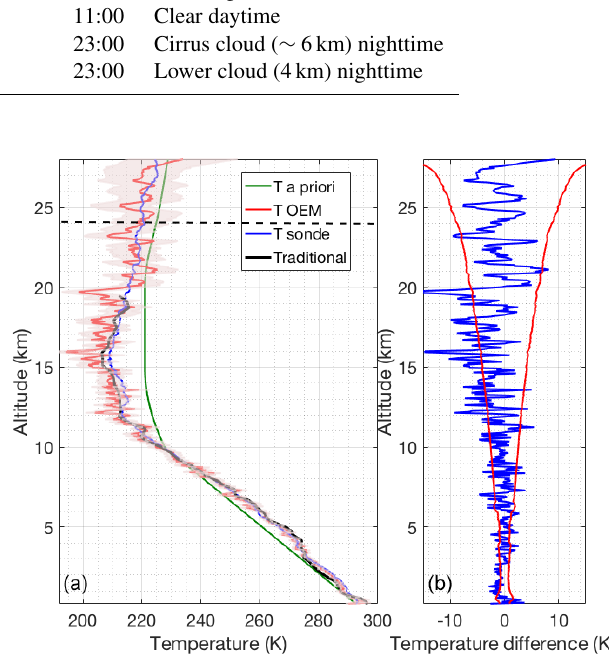
Figure 4. (a) Retrieved temperature profile and the statistical un- certainty (red curve and shaded area) using the OEM from the clear nighttime RALMO measurements on 9 September 2011. The blue curve is the radiosonde measurement. The sonde was launched at 22:00UT. The green curve is the a priori temperature profile used by the OEM. The black curve shows the temperature retrieved us- ing the traditional analysis method from glued analog and photon- counting signals. The horizontal dashed line shows the height below which the retrieval is due primarily to the measurement and not the a priori temperature profile. (b) The blue curve shows the tempera- ture difference between OEM-retrieved temperature and the sonde temperature. The red curves in the figure show the statistical uncer- tainty in the OEM